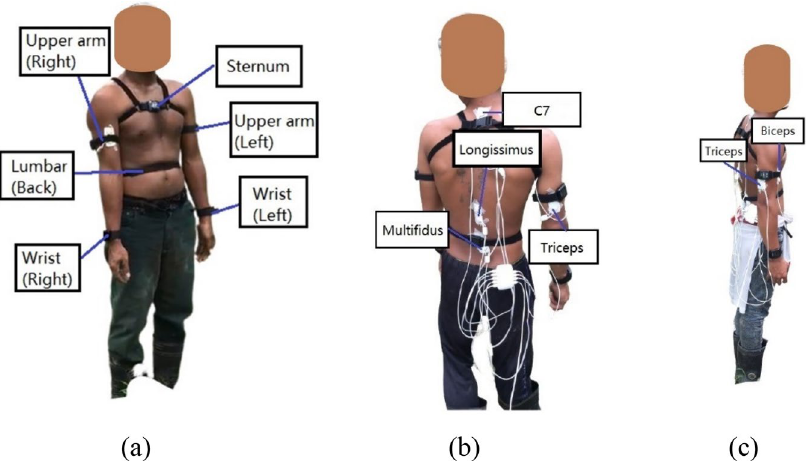
Figure 1. Location of ( a ) IMU sensors on the harvester, ( b ) EMG electrodes on muscles of interest from posterior view and ( c ) right side view, with reference electrode at the C7 region.